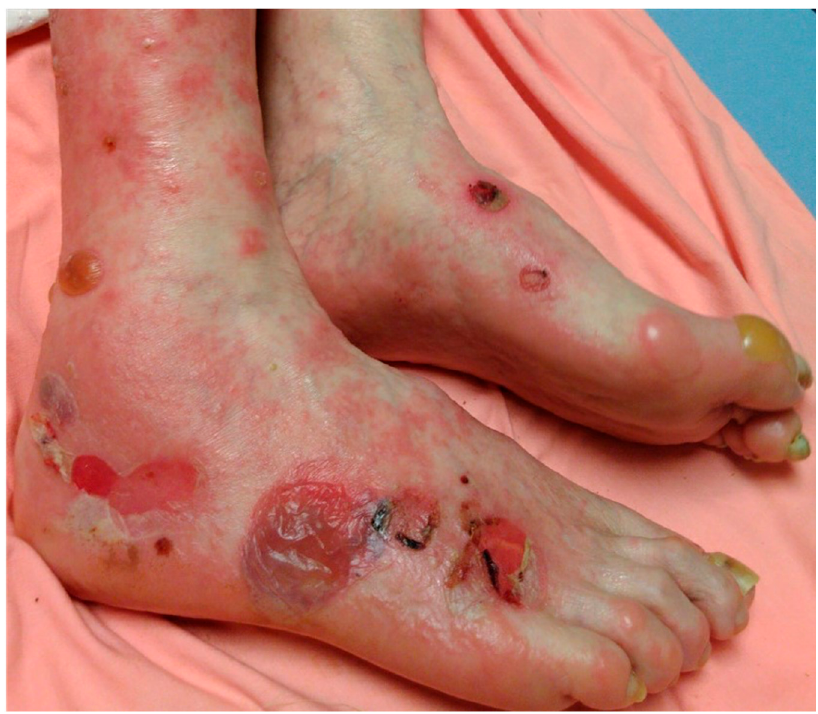
Figure 1 . Bullous pemphigoid. Tense bullae overlying erythematous to urticarial plaques on acral skin.